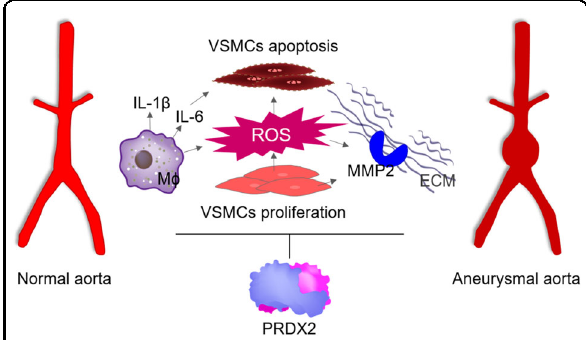
Fig. 7 PRDX2 prevents structural damage, oxidative stress, and in fl ammation during the progression of AAA. The levels of PRDX2 are augmented in aneurysmal aortas and participate in ameliorating the structural deterioration of aortas, ROS-mediated oxidative stress, and in fl ammatory responses induced by Ang II